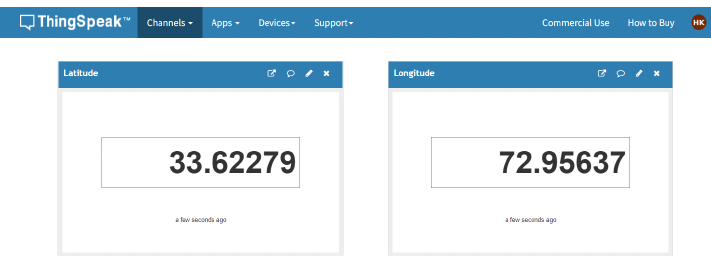
Figure 12. ThingSpeak IoT platform location